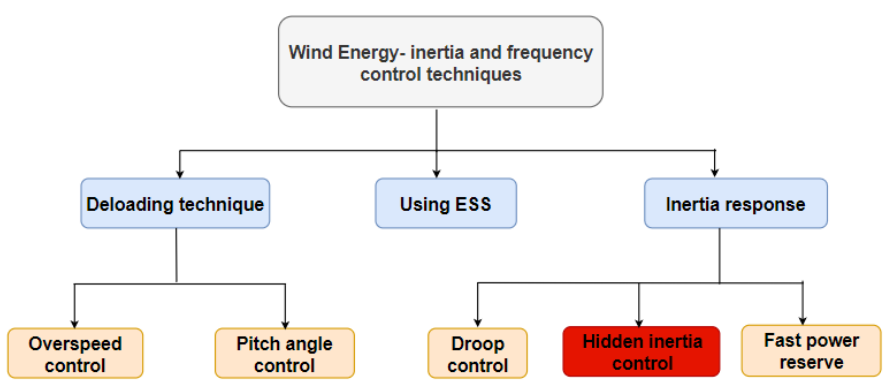
Figure 1. Classification of frequency control techniques in wind energy